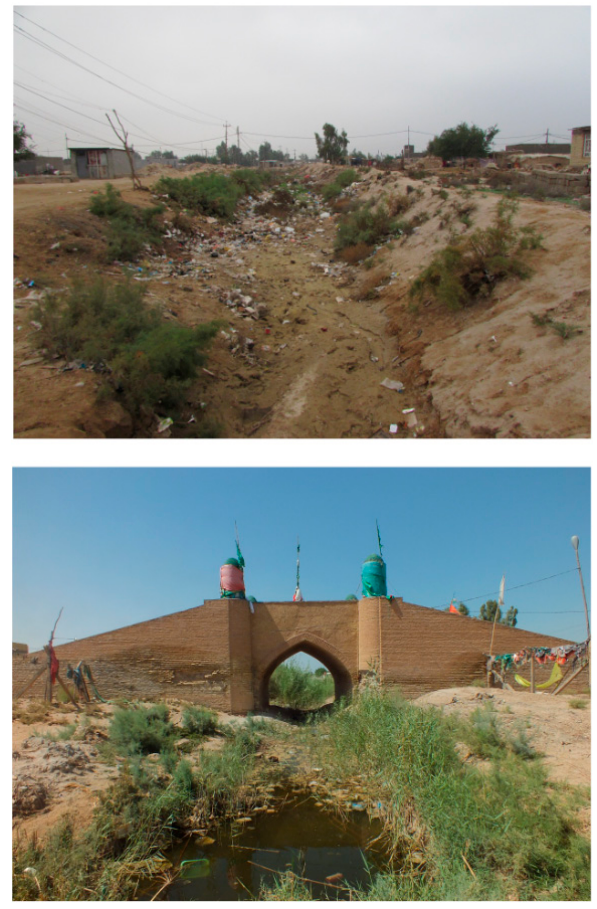
Figure 4. The Khandaq Shapur south of Karbala ( top ) and viewed from the historic Islamic bridge north of Kufa ( bottom ). On the ground, the feature can be visible as both a dry ditch ( top ) or filled with reeds and groundwater ( bottom ).